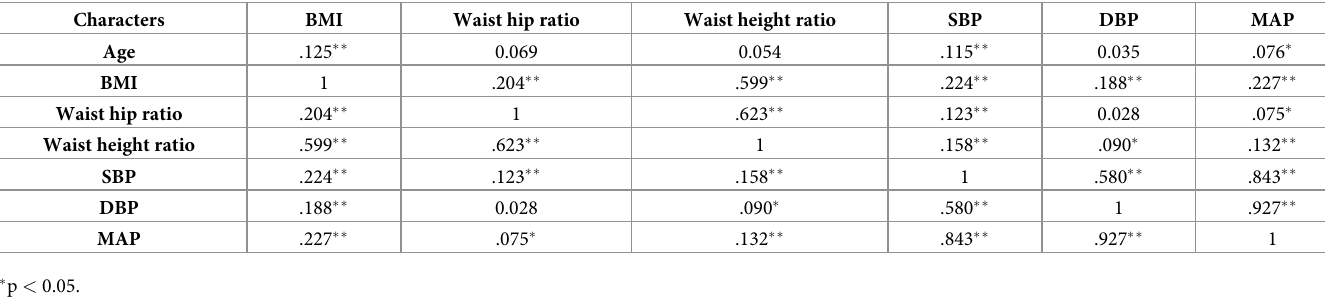
Table 4. Correlation of anthropometric measures with blood pressure (n =